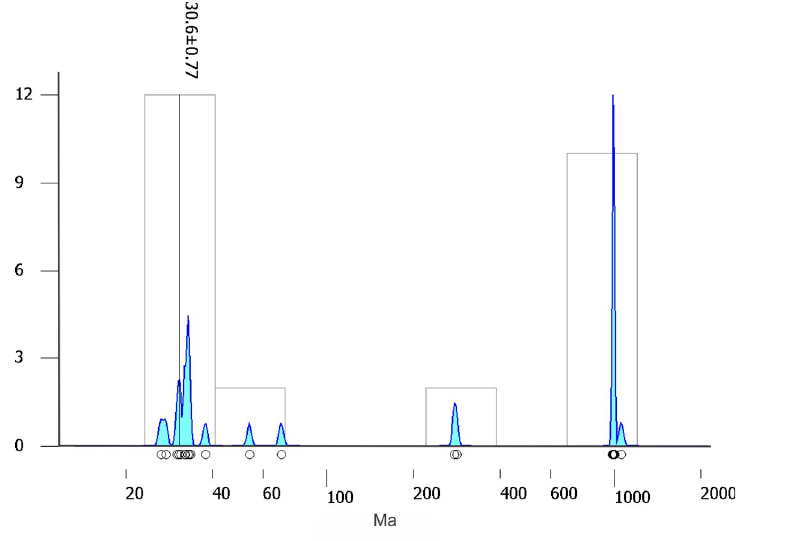
Fig 3. Maximum depositional age biased on U-Pb detrital zircon geochronology.